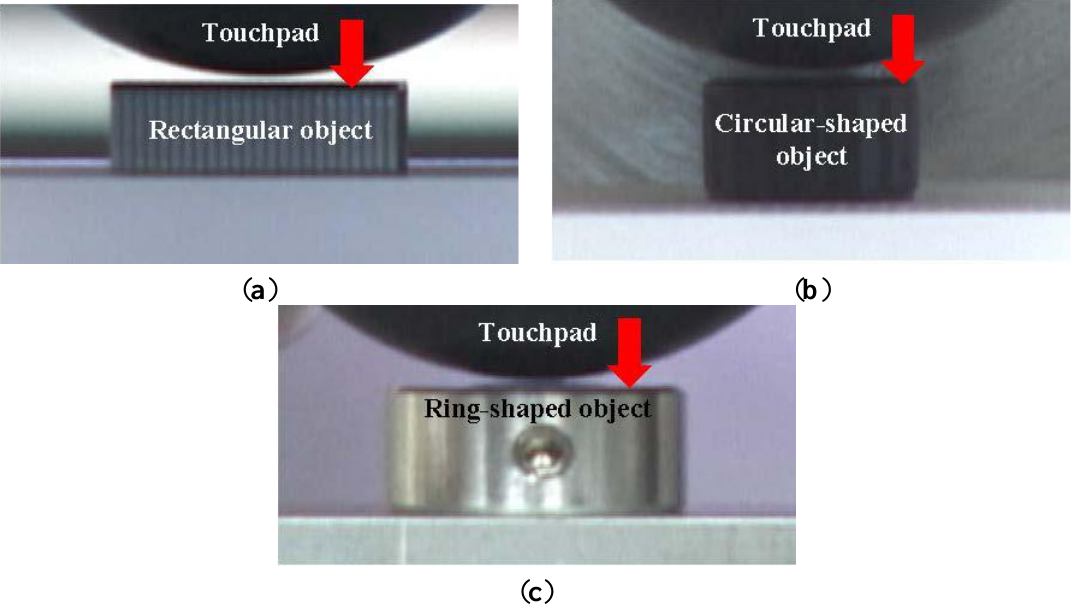
Figure 7. The side view images when ( a ) the touchpad was in contact with a